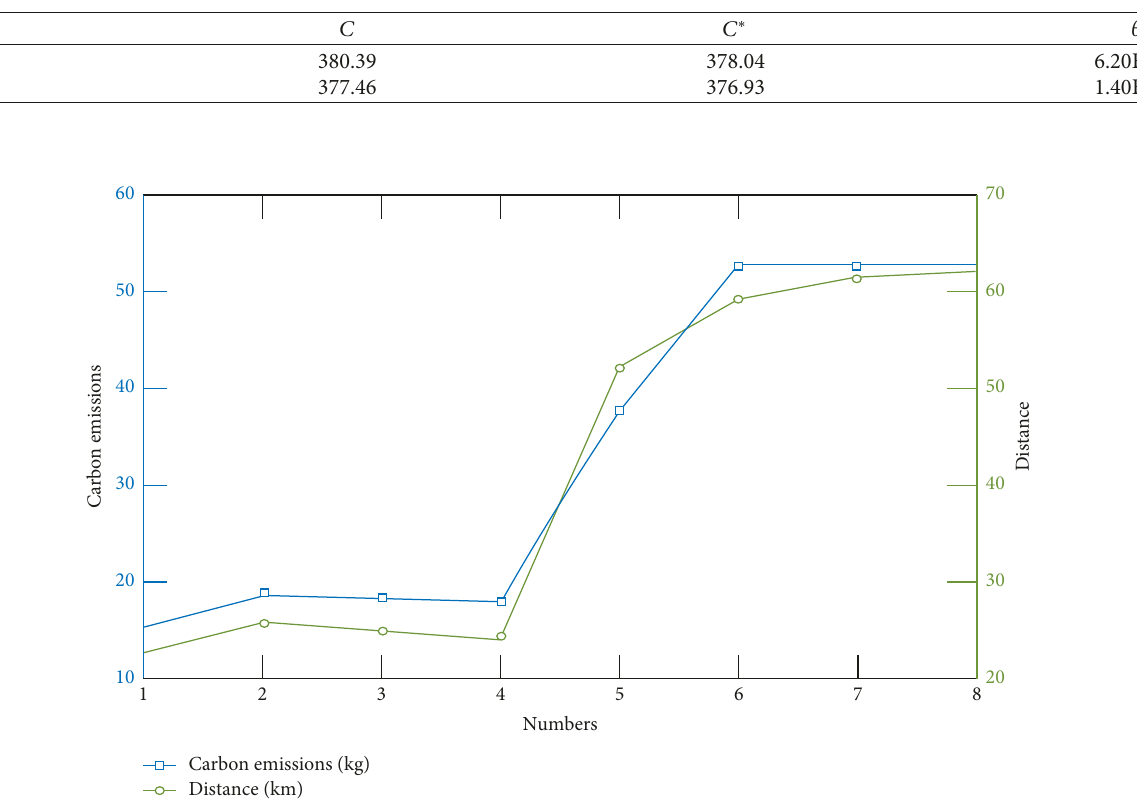
Table 9: The distribution schemes of cross-period time-varying network T